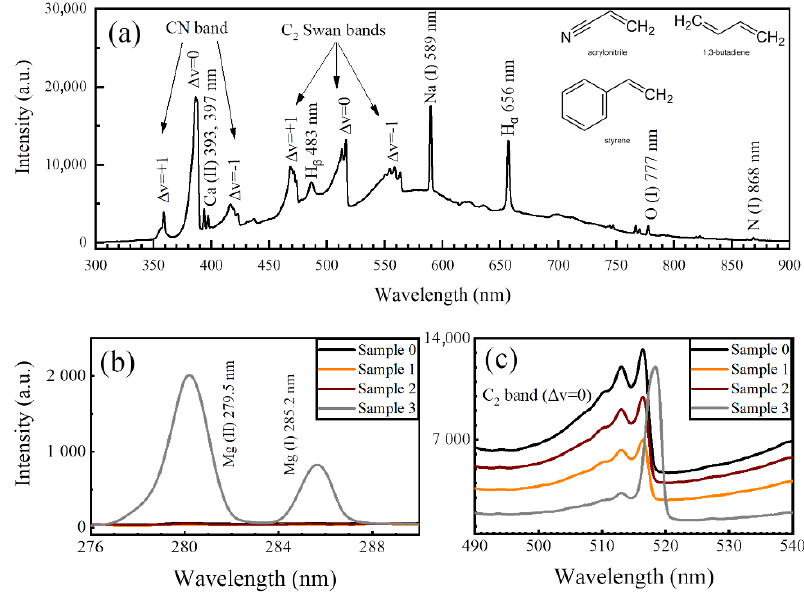
Figure 3. ( a ) LIBS spectrum of the matrix (i.e., sample 0). ( b ) Mg spectral lines of the sample 3, containing Mg(OH) 2 . ( c ) Interference of the Mg spectral lines with the C 2 band emission.